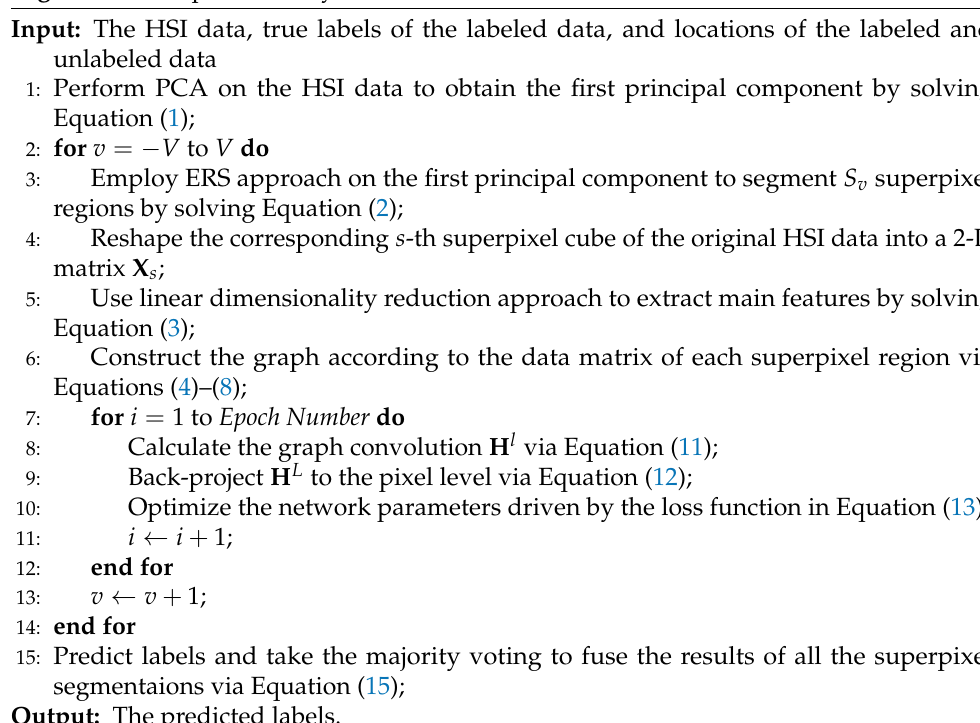
Algorithm 1 Proposed DRHy